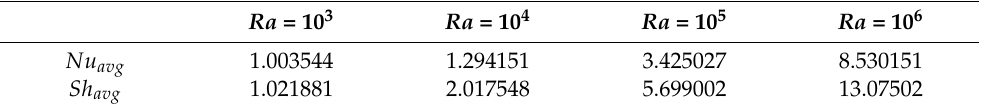
Table 3. Average Nu and Sh